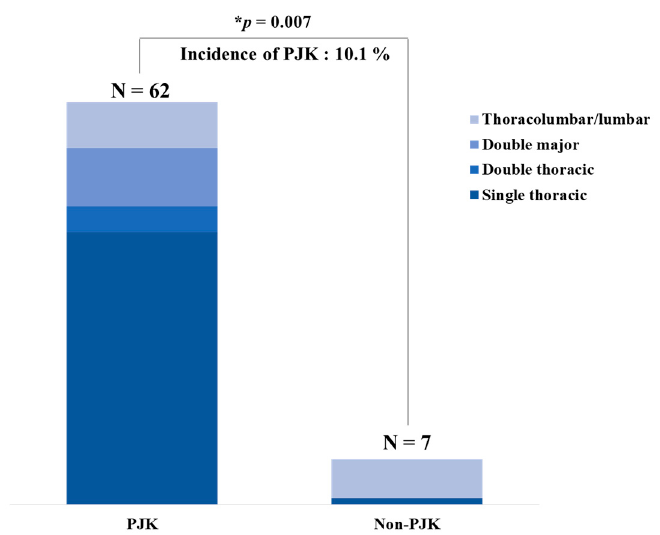
Figure 3. Incidence rate of proximal junctional kyphosis (PJK) in the patients with adolescent idiopathic scoliosis (AIS) following posterior segmental instrumentation (PSI) with direct vertebral rotation (DVR) and rod derotation (RD). Seven of 69 patients showed development of PJK (10.1%) within a mean 9.4-year follow-up period, showing a proportionally higher thoracolumbar/lumbar curve with statistical significance (* p = 0.007). N = number; * means p value < 0.05.